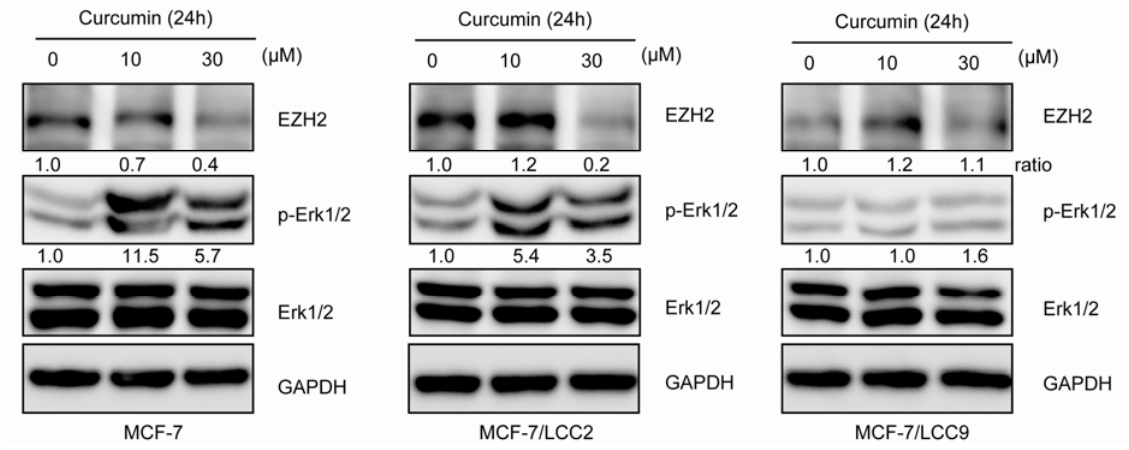
Figure 10. Curcumin inhibits EZH2 expression in MCF-7/LCC2. After treatment of indicated concentrations of curcumin for 24 h, cells were harvested and analyzed by western blot using antibodies to Erk1/2, p-Erk1/2 (Thr202/Tyr204) and